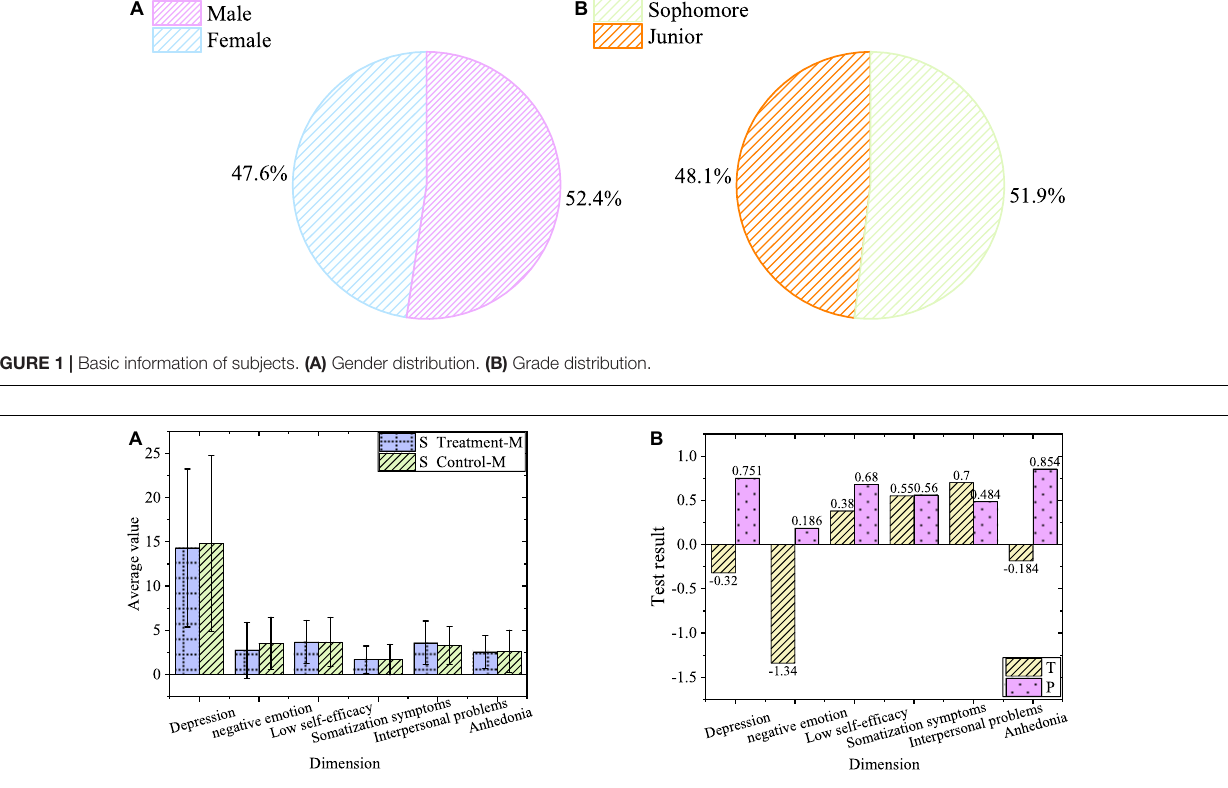
FIGURE 2 | Comparison of negative emotions of sophomores. (A) Average of treatment group and control group. (B) Value of T and P of treatment group and control group.